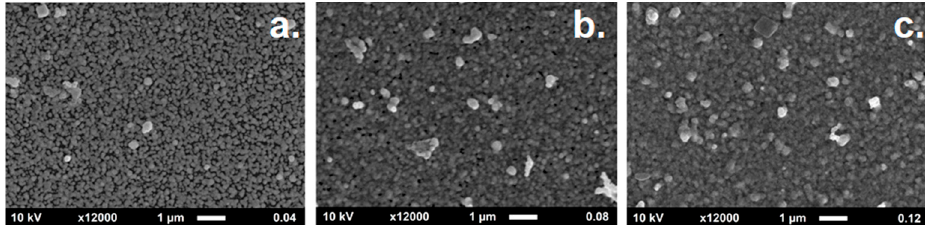
Figure 7. Scanning electron microscopy (SEM) images of the polyetheretherketone coated with one layer of silver nanoparticles in concentrations of (a) 0.04 mol/L, (b) 0.08 mol/L and (c) 0.12 mol/L. Figure 8. SEM images of the polyetheretherketone coated with two layers of silver nanoparticles in concentrations of (a) 0.04 mol/L, (b) 0.08 mol/L and (c) 0.12 mol/L.